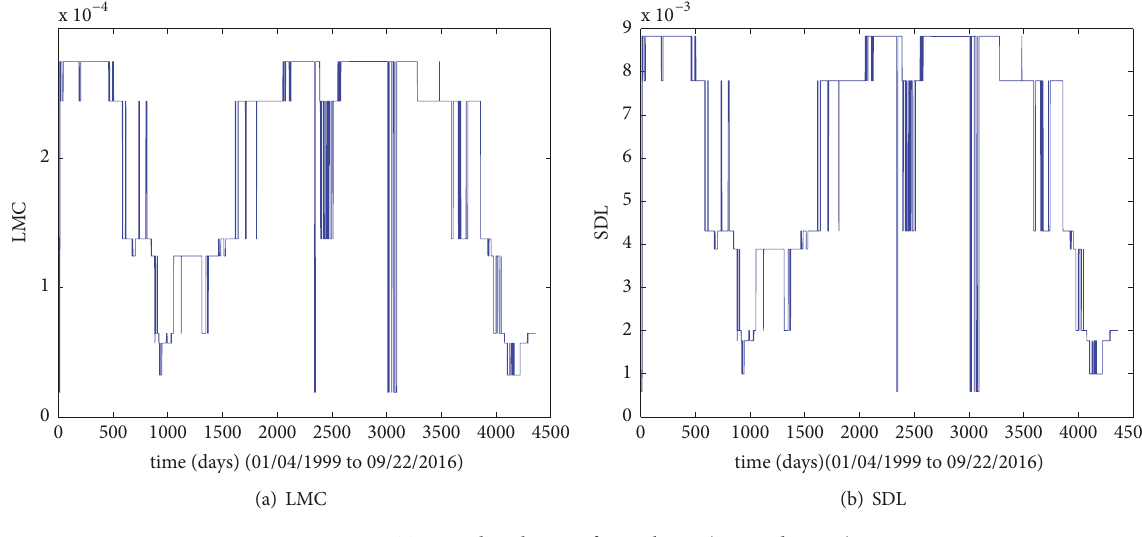
Figure 6: Temporal evolution of complexity (8-part division).